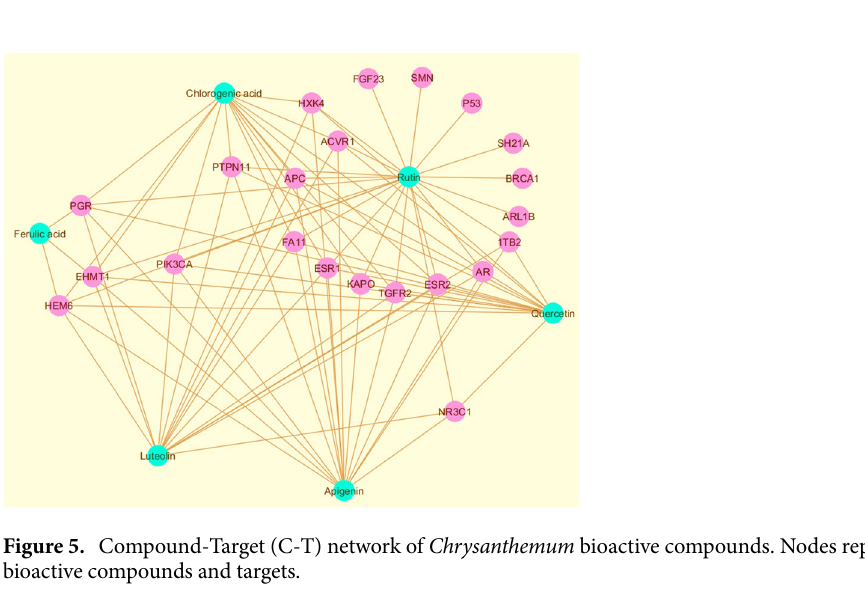
Figure 4. Gene ontology analysis of target genes of ( a ) six major Chrysanthemum compounds and ( b ) rutin.